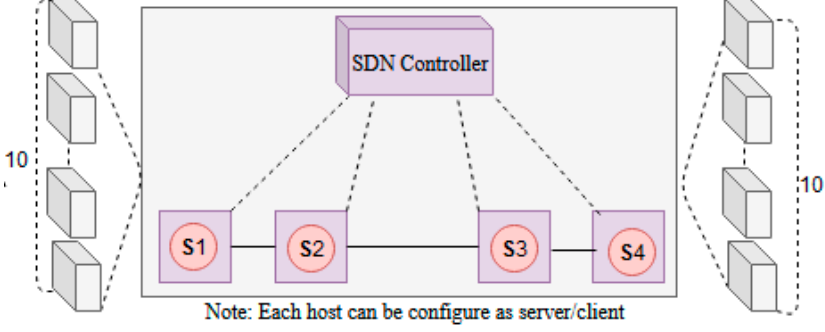
Figure 6: Network Topology configuration Figure 6. Network topology configuration.